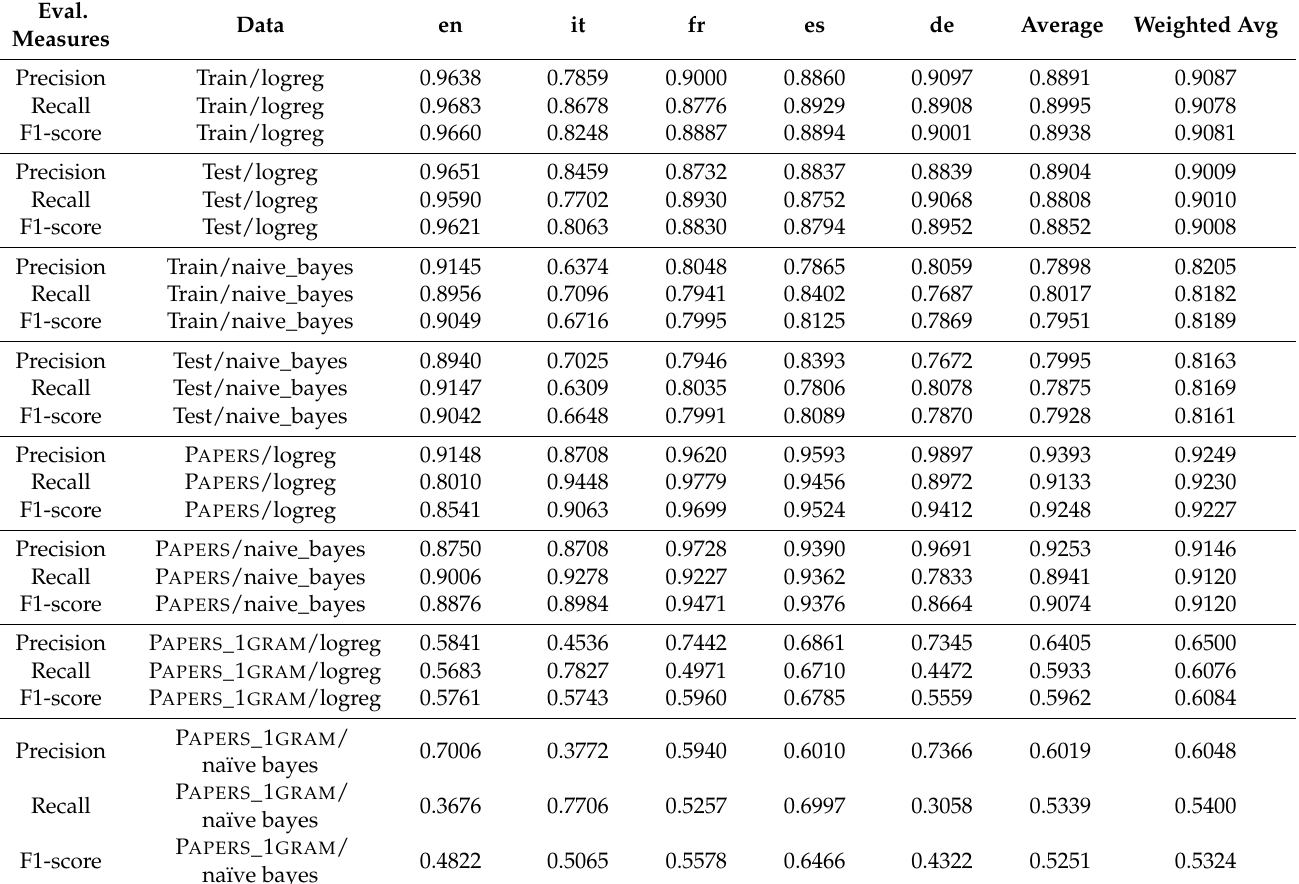
Table 3. Results for the classifiers trained on WIKI_NOOOV dataset, using character trigrams and 1200 max